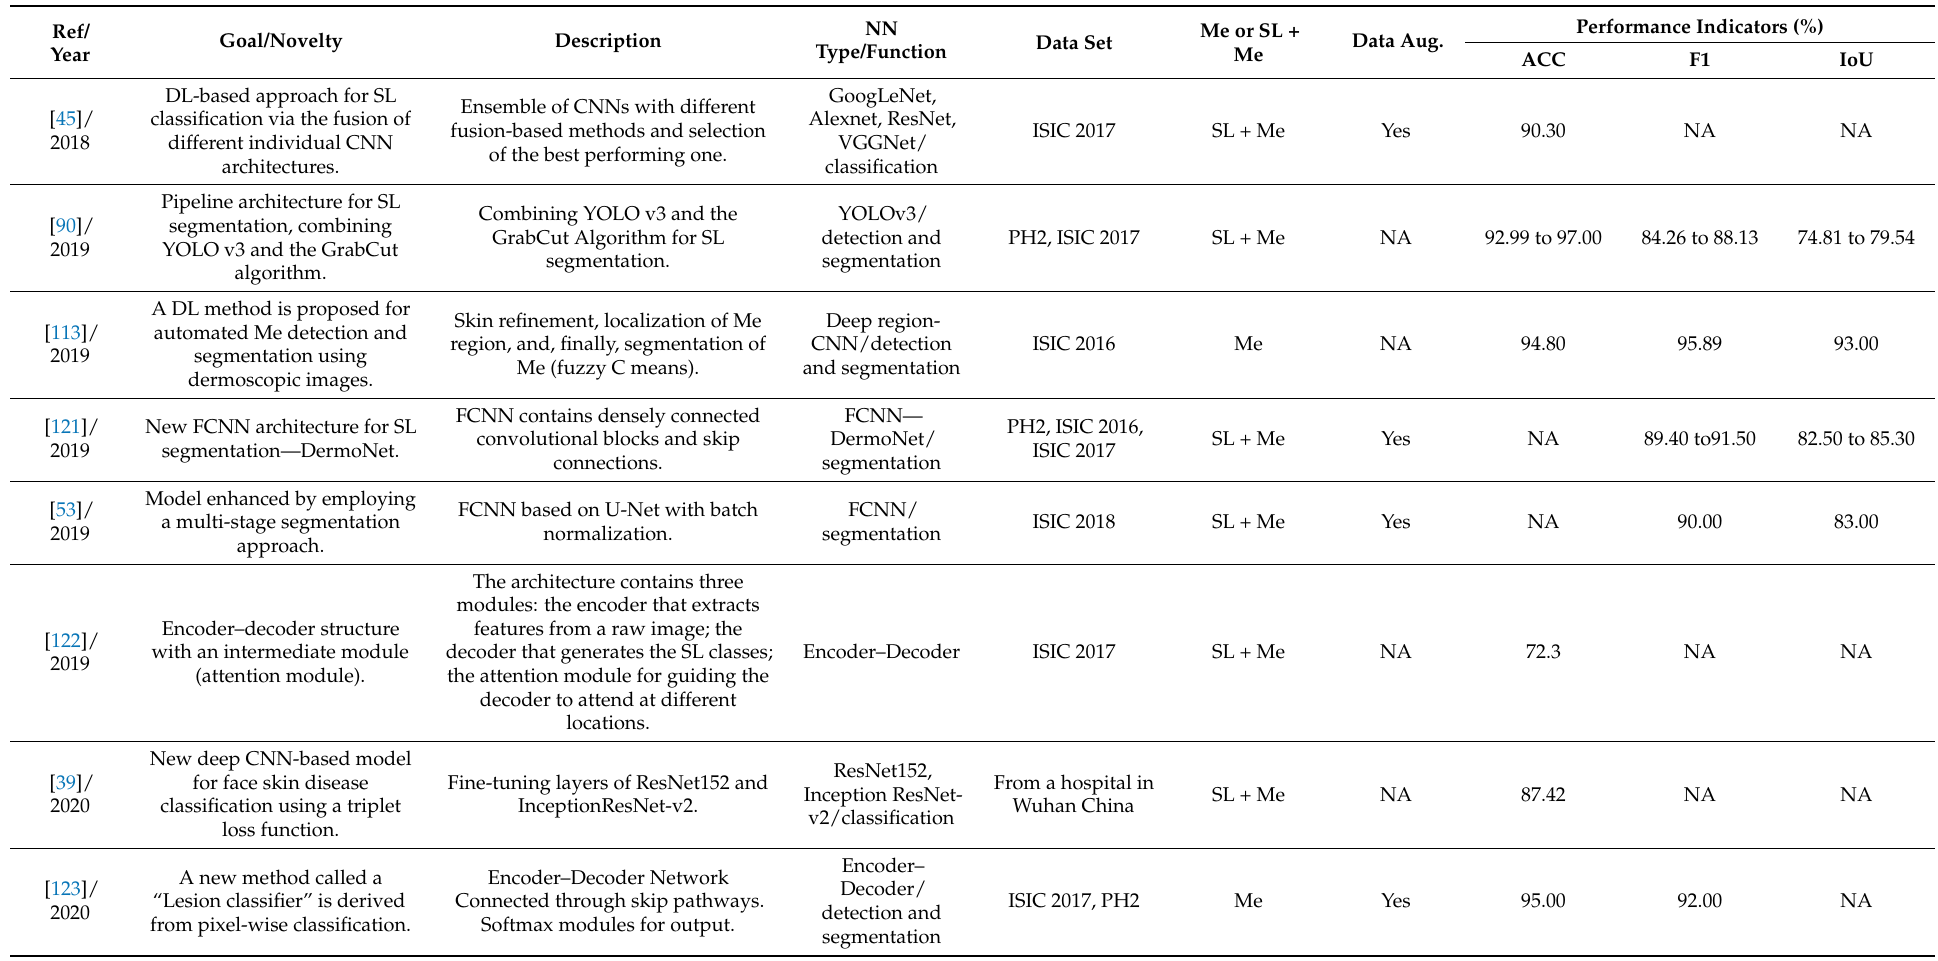
Table 4. Synthesis of the most important papers regarding the trends of using NN in Me and SL